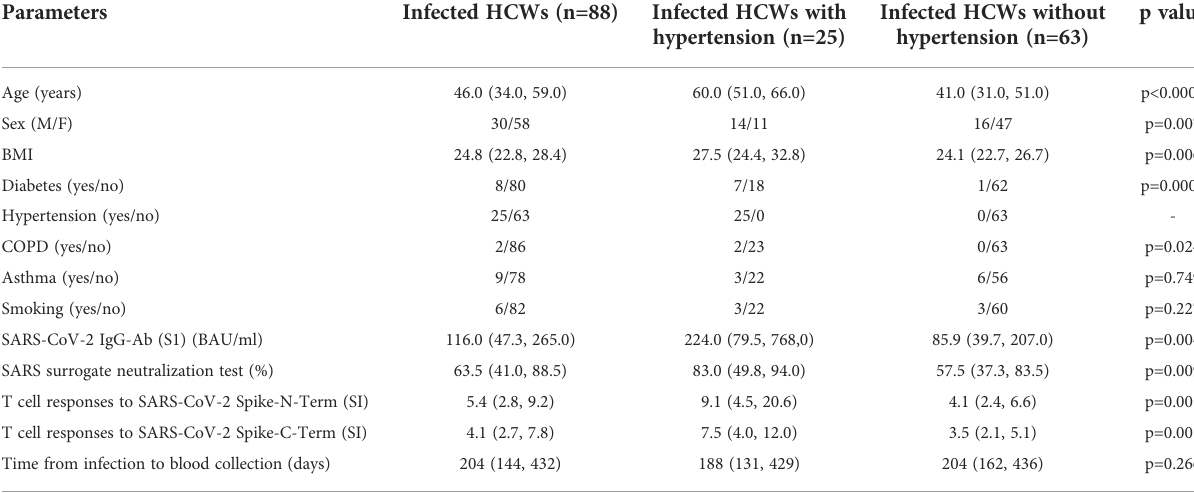
TABLE 1 Characteristics of SARS-CoV-2 infected health care workers (HCWs).